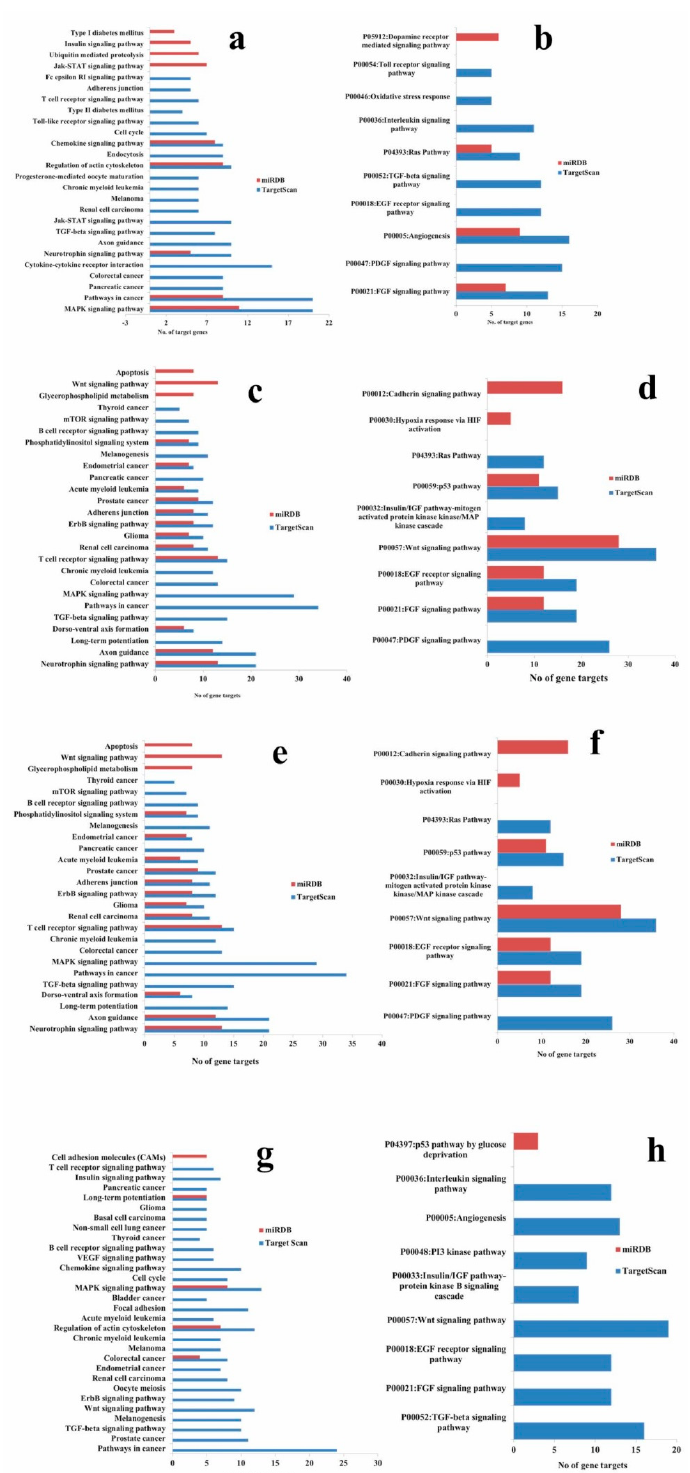
Figure 13. KEGG and PANTHER pathway enrichment of targets of validated microRNAs. ( a ) KEGG pathway analysis of hsa-miR-21-5p; ( b ) PANTHER pathway analysis of hsa-miR-21-5p; ( c ) KEGG pathway analysis of hsa-miR-548o-5p; ( d ) PANTHER pathway analysis of hsa-miR-548o-5p; ( e ) KEGG pathway analysis of hsa-miR-181c; ( f ) PANTHER pathway analysis of hsa-miR-181c; ( g ) KEGG pathway analysis of hsa-miR-212-5p; ( h ) PANTHER pathway analysis of